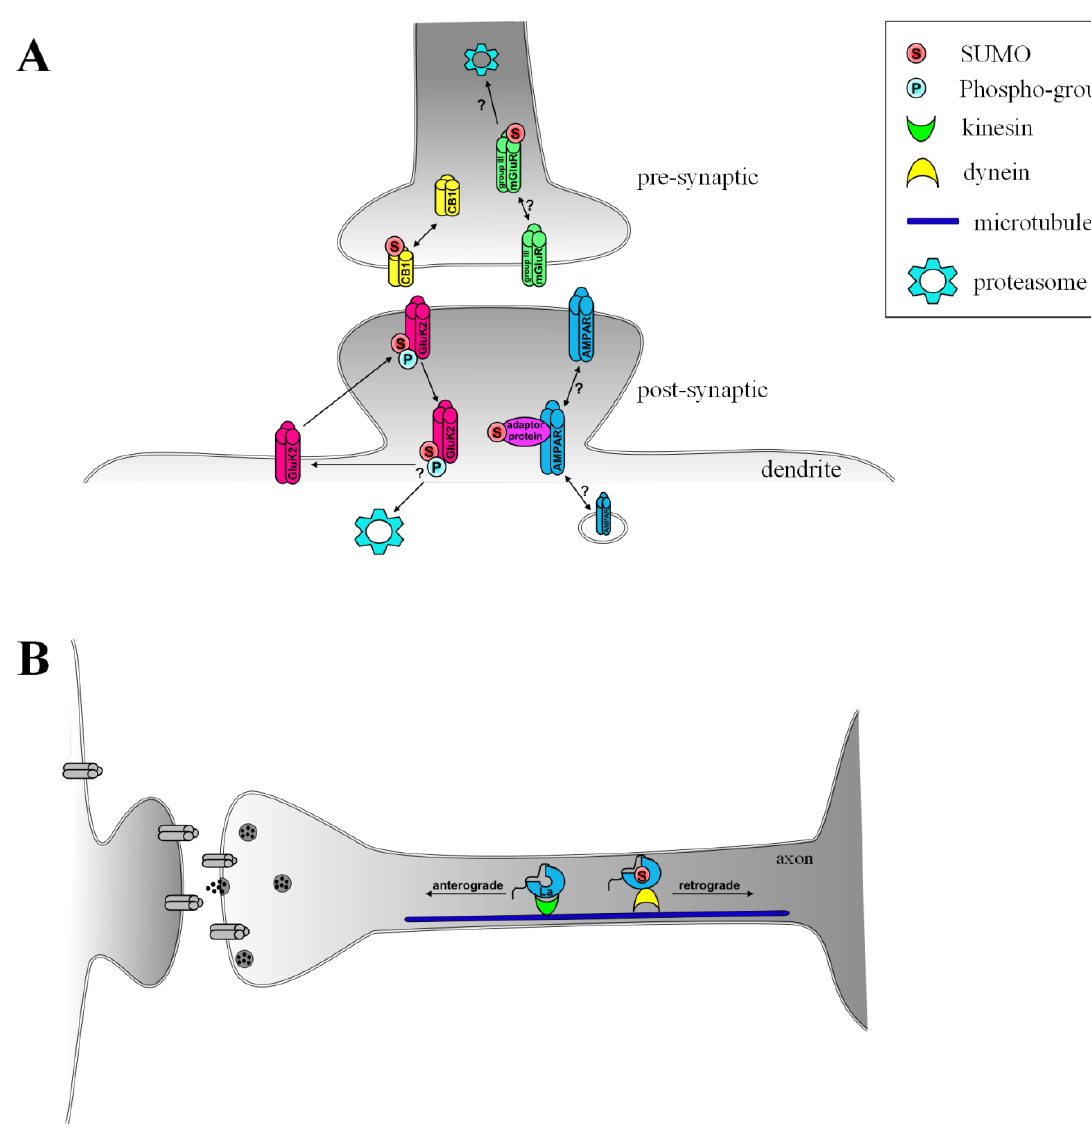
Figure 2. Influence of SUMOylation on receptor trafficking and protein transport. ( A ) At the pre-synapse, de-SUMOylation of the cannabinoid receptor CB1 is proposed to lead to its internalization. In contrast, SUMOylation of group III mGluRs may lead to internalisation and/or degradation. Agonist-induced phosphorylation of GluK2 in post-synaptic kainate receptors causes endocytosis. Potential SUMO regulation of AMPA receptors may be via SUMO modified interacting proteins; ( B ) In the axon, the RNA binding protein La is SUMOylated, triggering its retrograde axonal transport through binding to